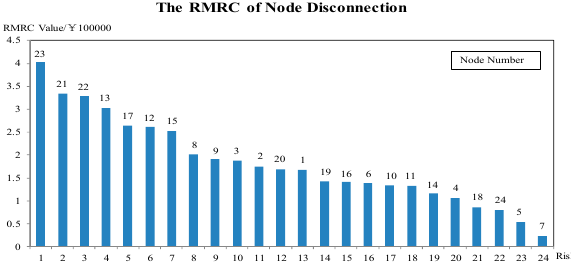
Figure 3. Diagram of the RMRC of the node disconnection in RTS-79 system.